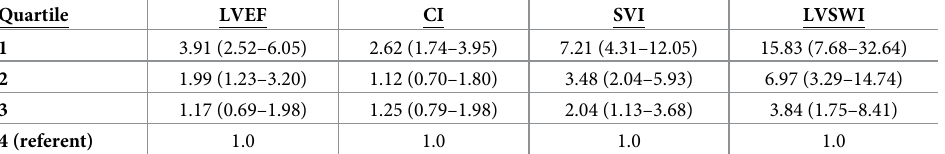
Table 3. Unadjusted odds ratio (OR) and 95% confidence interval values for quartiles of selected echocardio- graphic for prediction of in-hospital mortality using univariable logistic regression, with Quartile 4 as referent. Median and interquartile range values defining the quartiles are as follows: ECHO LVSWI, 37.0 (21.0, 46.1) J/m2; CI, 2.8 (2.4, 3.3) L/min/m2; LVEF, 51 (36, 61) %; SVI, 41 (33, 47) ml/m2.